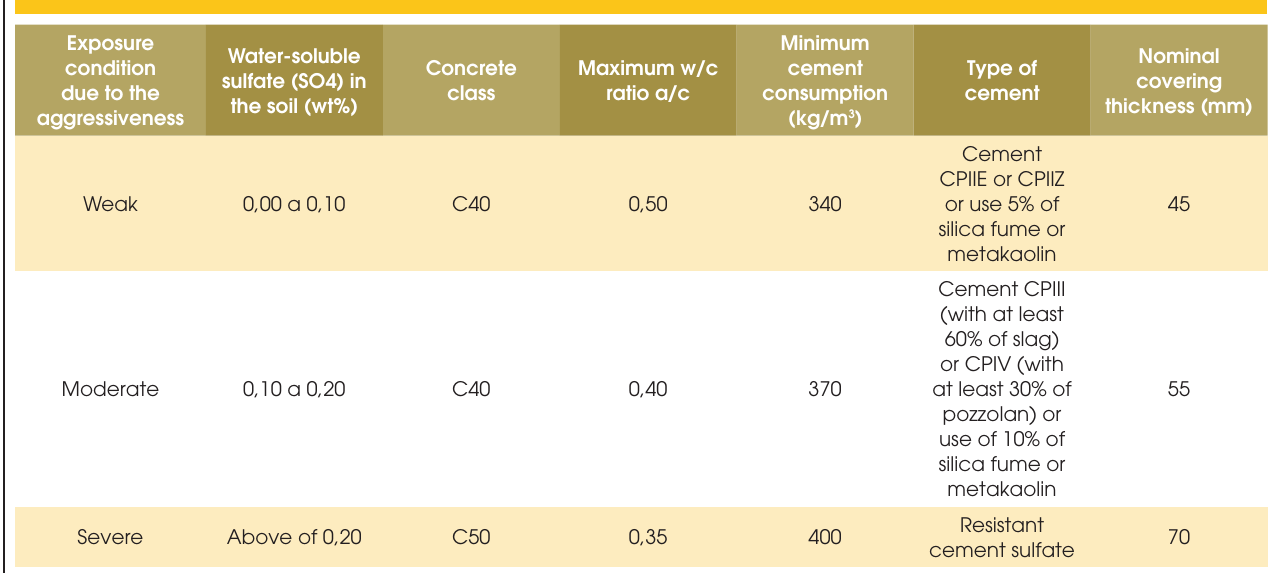
Table 14 – Recommendations for specification of concrete to meet service life of 75 years for buried